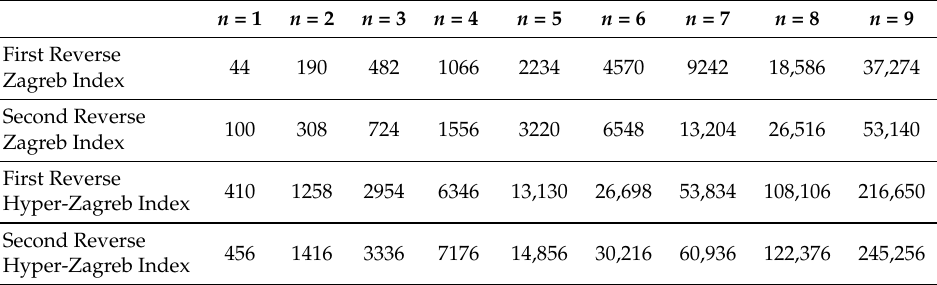
Table 2. Topological indices of PETIM